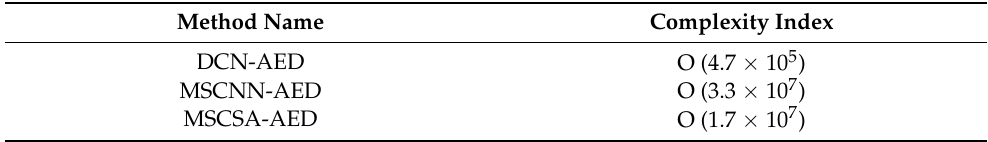
Table 4. Complexity analysis of the